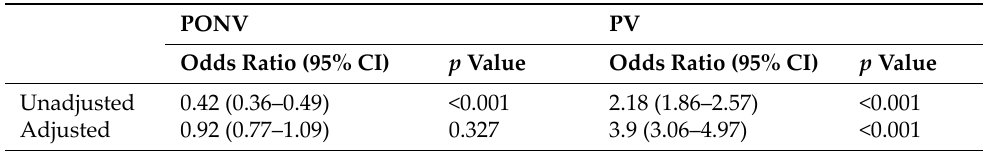
Table 2. Odds ratio of pregnancy on developing PONV and PV in female who underwent nondeliv‑ ery surgery. PONV PV Odds Ratio (95% CI) p Value Odds Ratio (95% CI) p Value Unadjusted 0.42 (0.36–0.49)